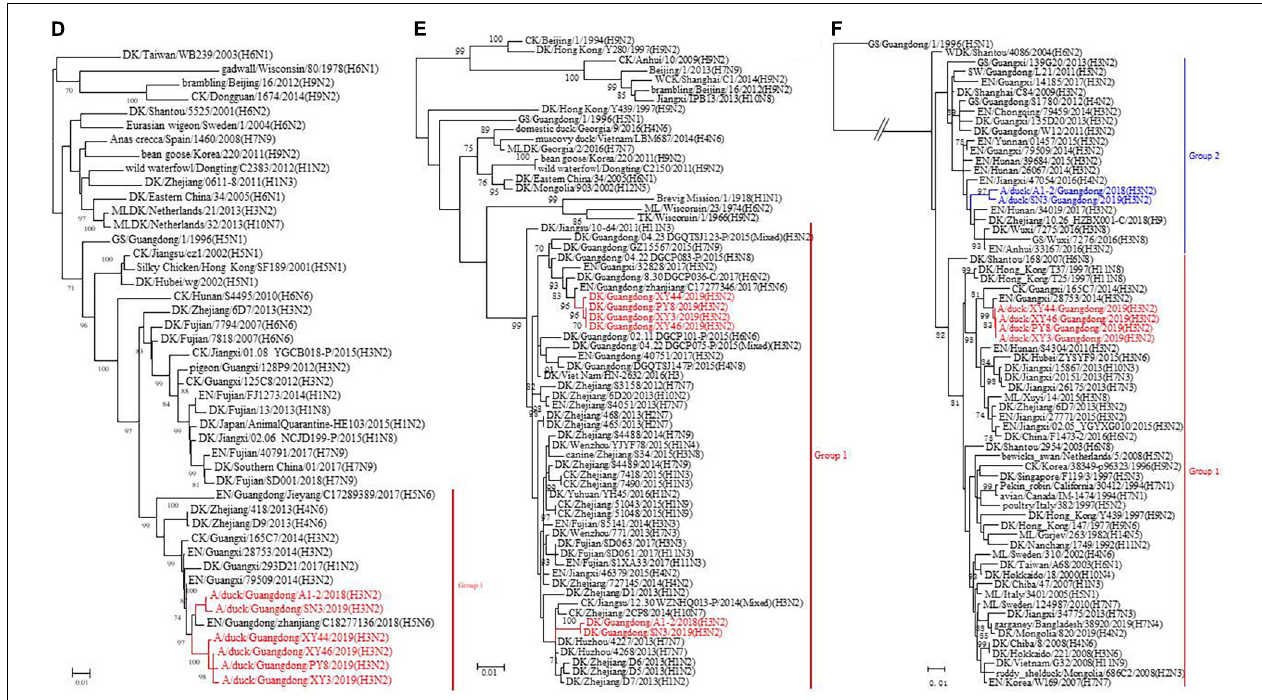
FIGURE 3 | Phylogenetic analysis of the surface genes of H3N2-subtype AIVs isolated from 2018 to 2019 using the maximum likelihood method. (A) PB2, (B) PB1, (C) PA, (D) NP, (E) M, and (F) NS. Phylogenetic trees were generated with the MAGE 7.0 software package. The evolutionary history was inferred using the maximum likelihood method based on the Tamura-Nei model. The tree with the highest log likelihood (–10541.1792) is shown. The percentage of trees in which the associated taxa clustered together is shown next to the branches. The initial tree(s) for the heuristic search were obtained by applying the neighbor-joining method to a matrix of pairwise distances estimated using the maximum composite likelihood (MCL) approach. The tree is drawn to scale, and the branch lengths indicate the number of substitutions per site. All positions containing gaps and missing data were eliminated. The phylogenetic trees of the 6 genes were obtained without a root tree. The sequences of viruses listed in black were downloaded from available databases. The viruses listed in red, blue, and green were sequenced in this study. CK, chicken; DK, duck; GS, goose; SW, swine; ML, mallard; WDK, wild duck; EN, environment.